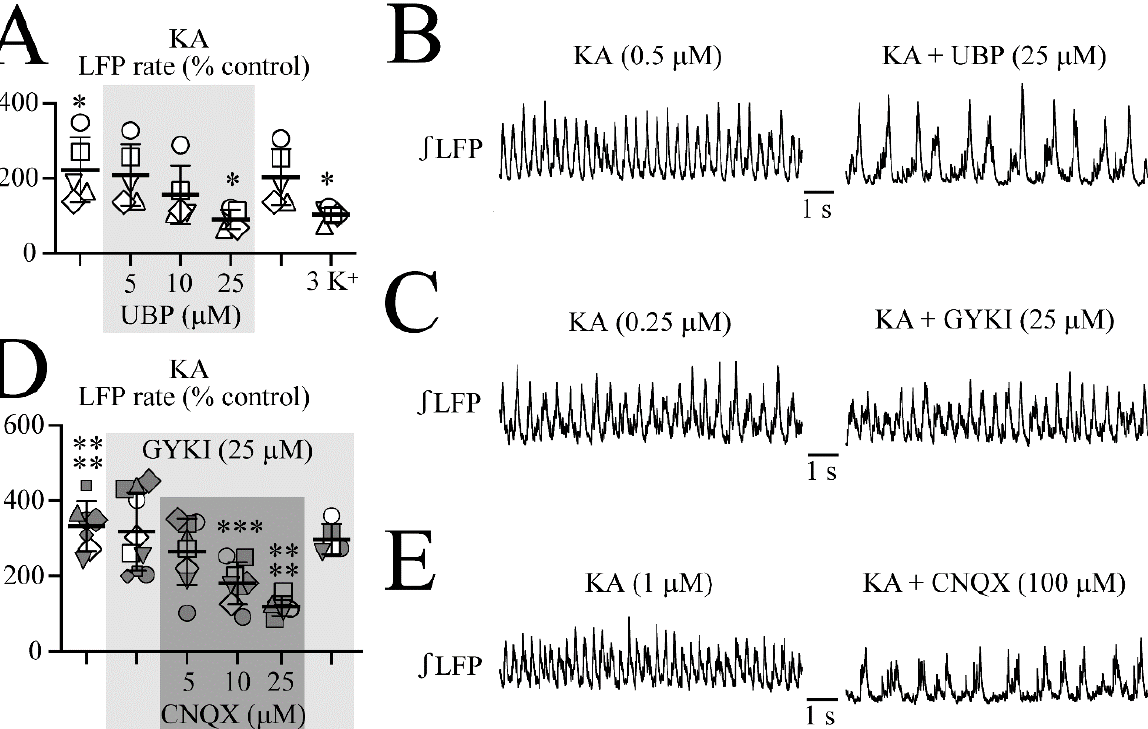
Figure 11. Effects of iGluR blockers on KA-evoked LFP oscillations. ( A , B ) The LFP oscillations due to either 0.25 or 0.5 µM KA were 222% faster than the control rhythm. (Each slice is represented by the same symbol.) An addition of 25 µM UBP reversed the LFP oscillations whereas 5 and 10 µM had no effect. UBP depression of KA-evoked LFP oscillations reversed within <10 min after the start of the wash of the blocker and the control rhythm was restored also within <10 min after the start of the KA wash. ( C , D ) The KA-induced LFP oscillations were not countered by 25 µM GYKI, but by 10 and 25 µM CNQX whereas 5 µM had no effect. ( D ) The KA-evoked LFP oscillations were also blocked by CNQX in the absence of GYKI. Significances (* p < 0.05, *** p < 0.001, **** p < 0.0001) in ( A , D ) were obtained with a one-way ANOVA with Dunnett’s post-test. ( E ) exemplifies that also KA-evoked LFP oscillations in control superfusate without GYKI were countered by CNQX.